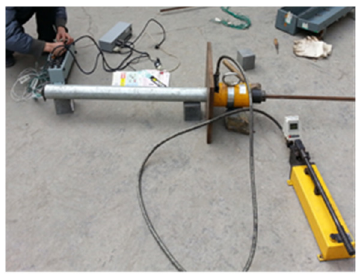
Figure 5. Forming diagram of rock bolt specimens.